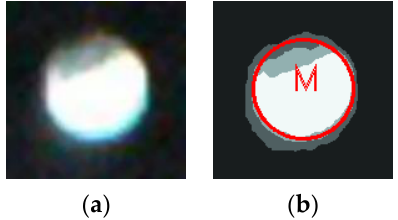
Figure 9. White solid circle marking point and contour extraction: ( a ) A marking point of the white solid circle, and ( b ) A contour of the complete white solid circle marking point.